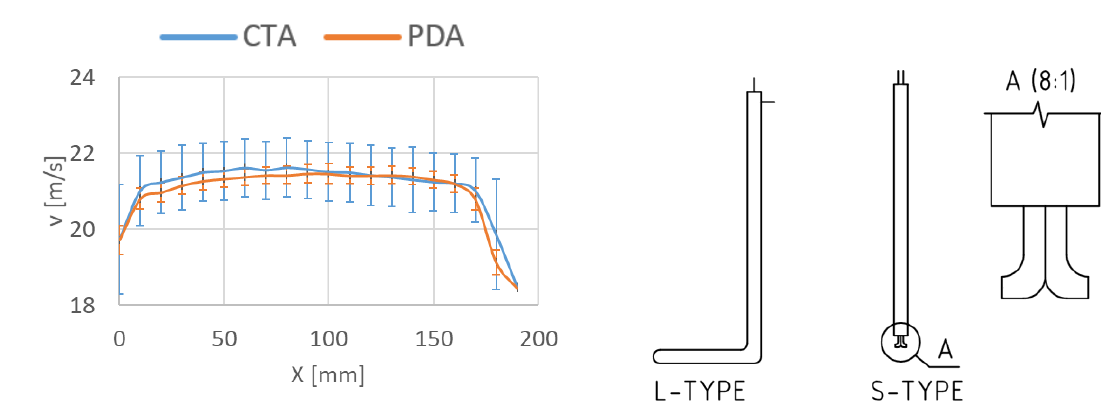
Fig. 15. Uncertainty of velocity measurement for PDA and CTA systems .